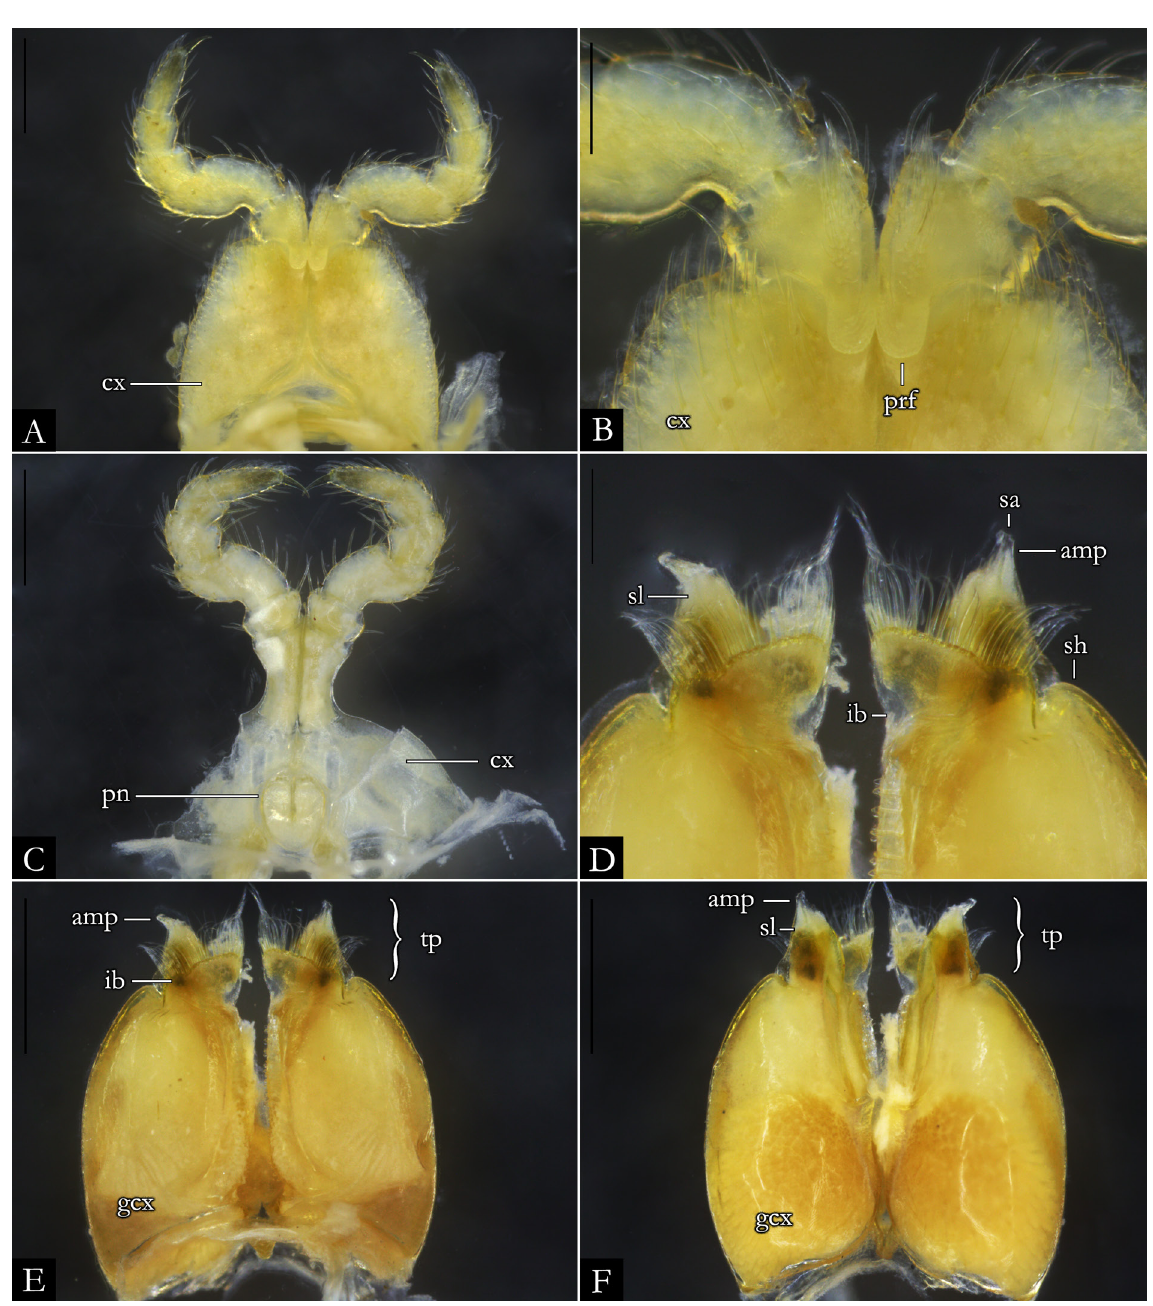
Fig. 141. Pseudonannolene urbica Schubart, 1945, ♂ (IBSP 2007). A . First leg-pair. B . Detail of prefemur. C . Second leg-pair. D . Detail of telopodites, in anal view. E . Gonopods, in anal view. F . Gonopods, in oral view. Abbreviations: see Material and methods. Scale bars: A, C, E–F = 0.5 mm; B, D = 0.2